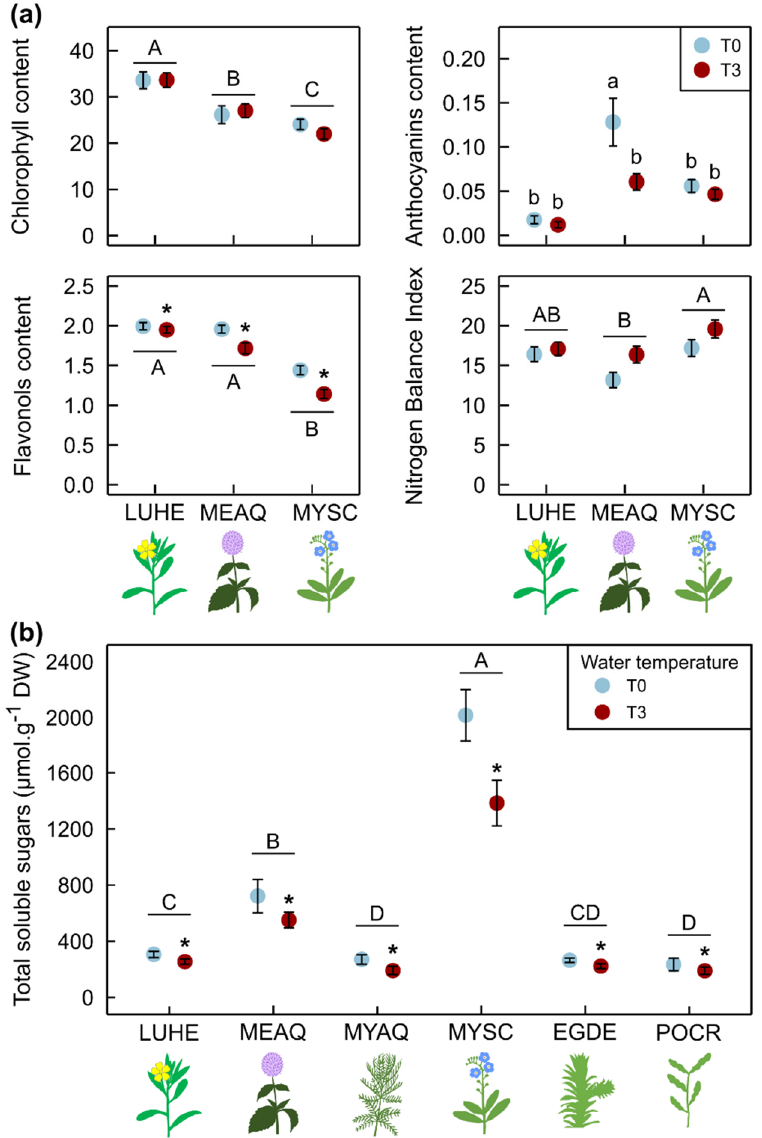
Figure 4. Chlorophyll, anthocyanins, flavonols contents and Nitrogen Balance Index ( a )—mean ± 95% CI, n = 5) for emergent species with wide enough leaves, and total soluble sugars for six species ( b )—mean ± 95% CI, n = 15) after exposure to ambient water temperature (T0) and to a 3 °C warming (T3) for 20 weeks. Stars indicate a significant difference compared to control (Two-way ANOVAs). Capital letters show differences among species, and small letters indicate an interaction between species and temperature. LUHE = Ludwigia hexapetala , MEAQ = Mentha aquatica , MYAQ = Myriophyllum aquaticum , MYSC = Myosotis scorpioides , EGDE = Egeria densa , POCR = Potamogeton crispus . Overall, total soluble sugars were 23% lower when plants had been exposed to a 3 °C sugars in M. scorpioides was 1650 µmol-g − 1 DW, a value 2.6-fold to 7.8-fold greater than that of the five other species. M. aquatica presented the second-highest amount in total